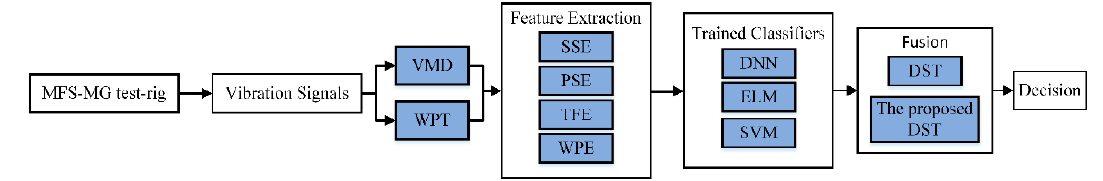
Figure 5. Flowchart of the proposed procedure.